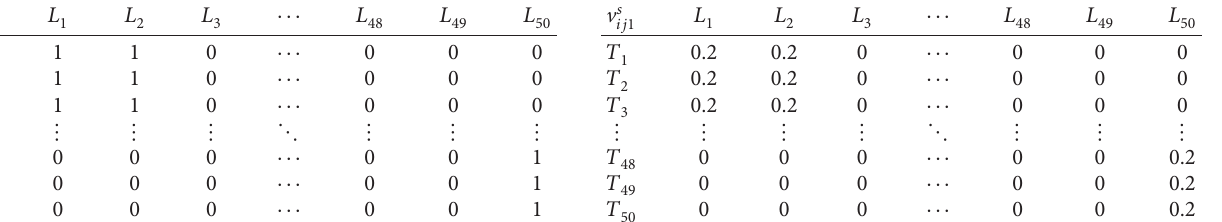
� [ v s ] for landlords’ ij 1 50 × 50 1